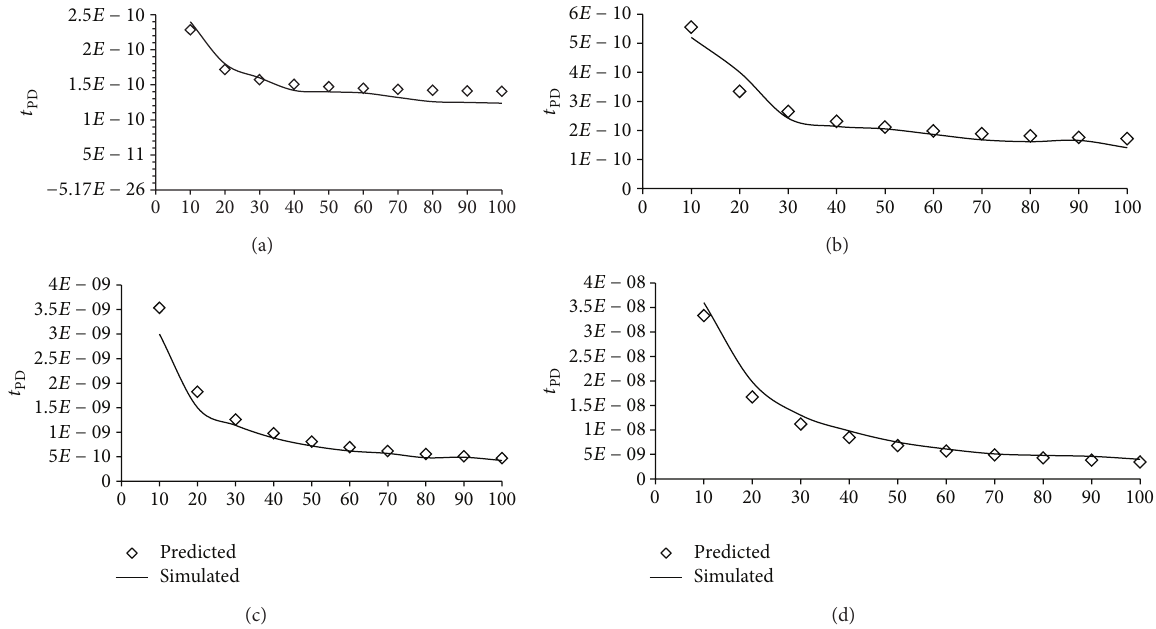
= 4 , and different load capacitances (a) v